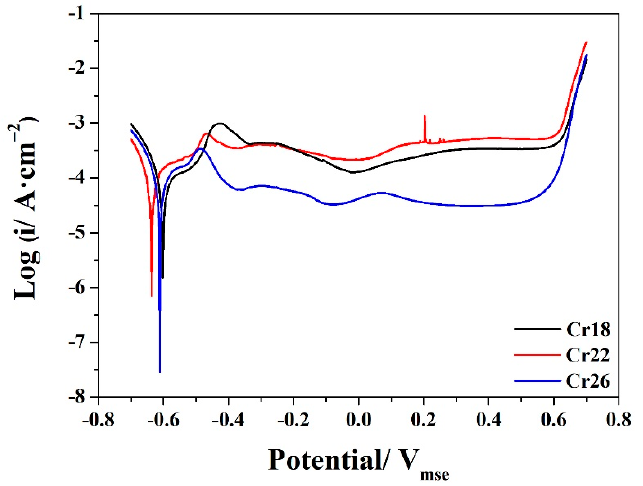
Figure 7. Potentiodynamic polarization curves of Ni-Cr-Mo alloy coatings in 50 wt.% H 2 SO 4 solution at 60 °C.